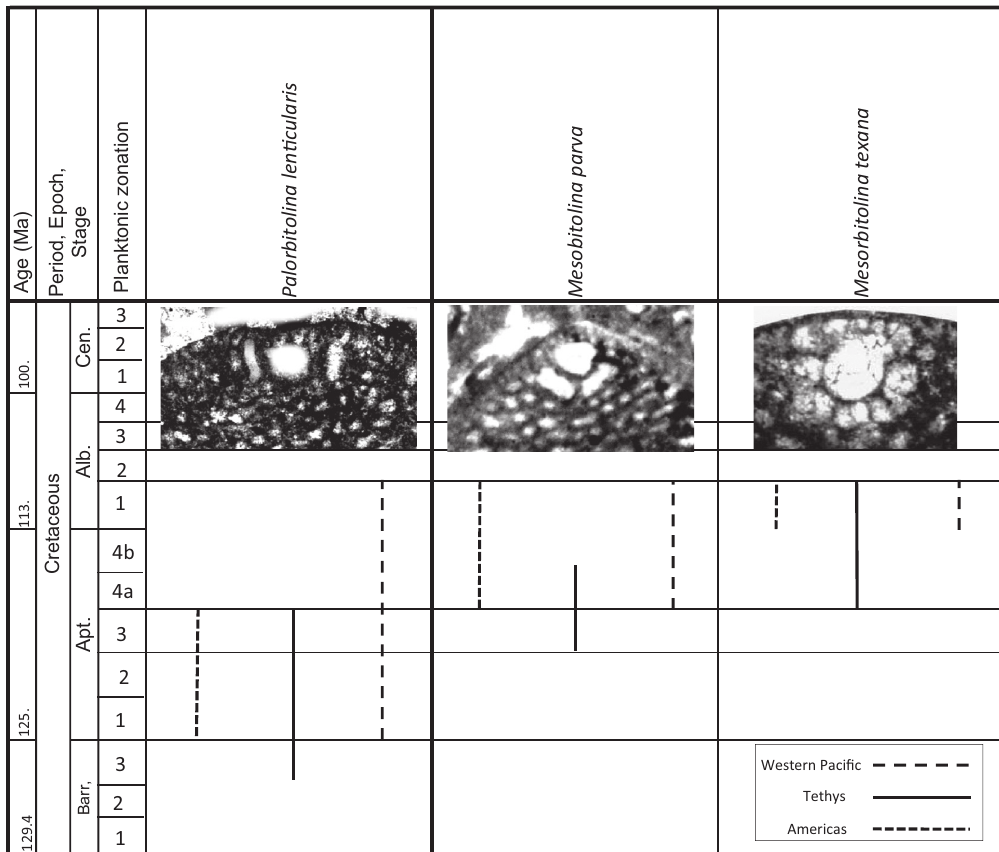
Range chart for some key orbitolinid species from Group (v) in the Tethyan and Western Pacific, and the American